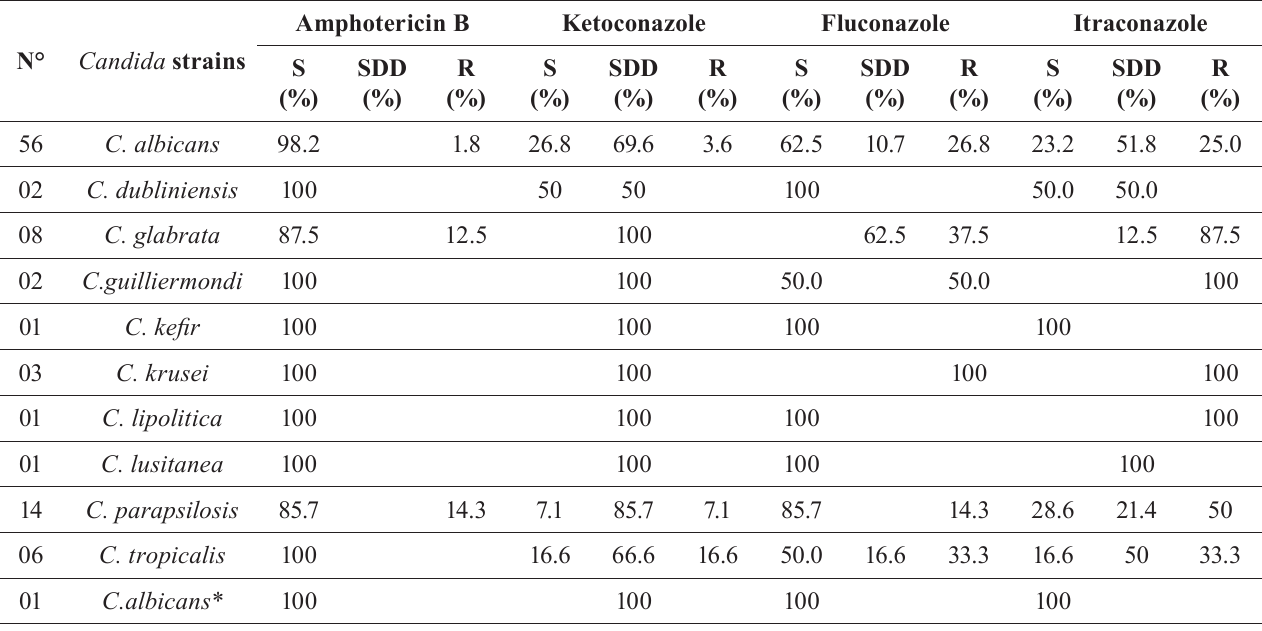
Table II – Susceptibility profile of isolates from Candida spp. to antifungals